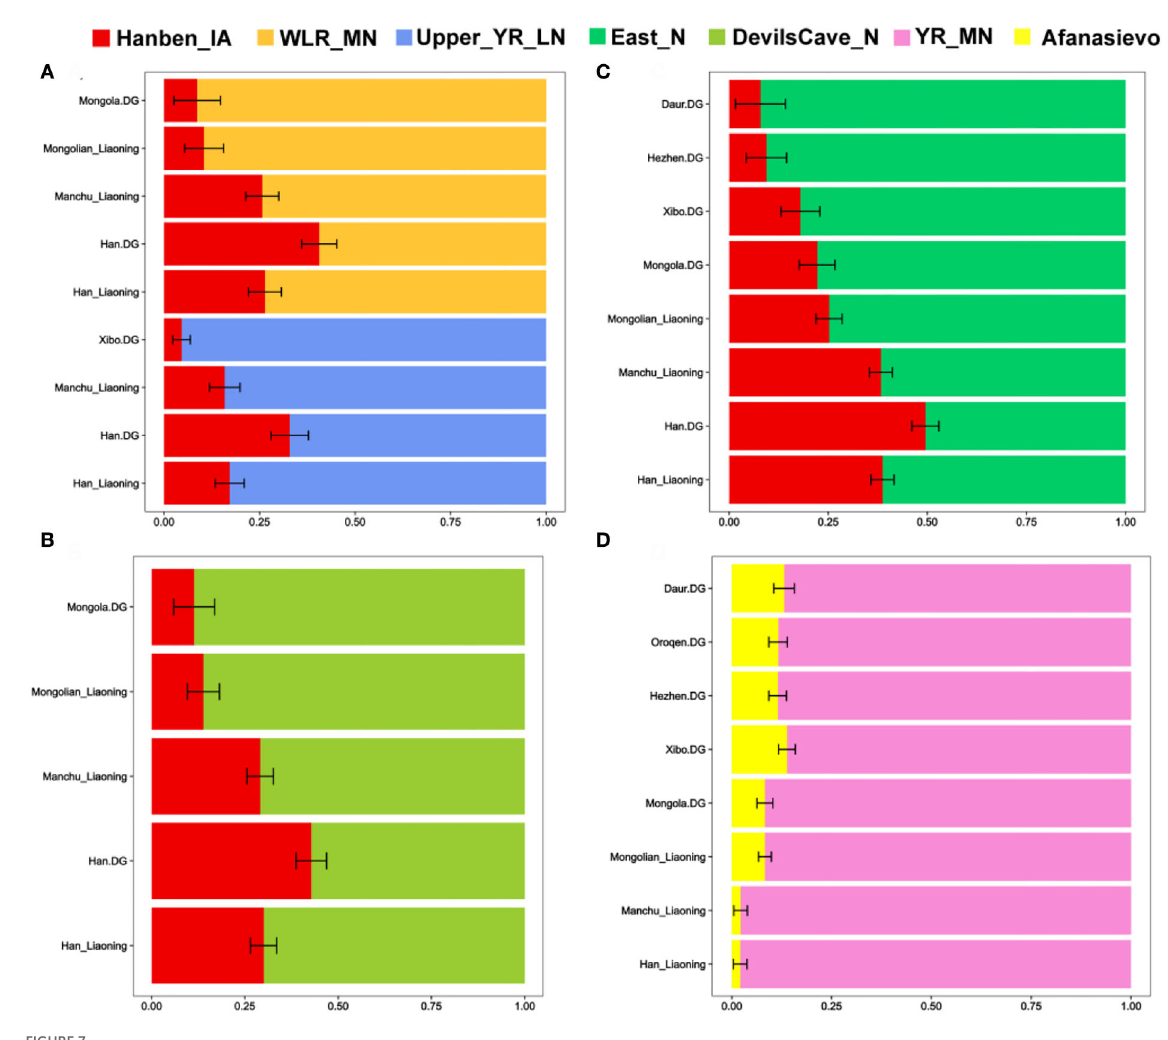
FIGURE7 (A–D) Two-way admixture model between Liaoning Han and other northern populations constructed based on the “Merged-1240K”